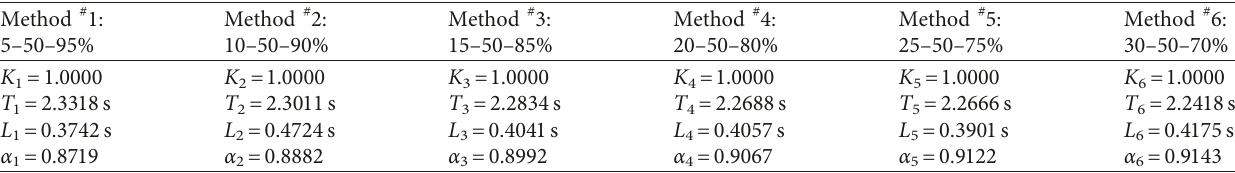
Table 14: FFOPDT model parameters for the considered sets of representative points (5–50-95%), (10–50–90%), (15–50–85%),